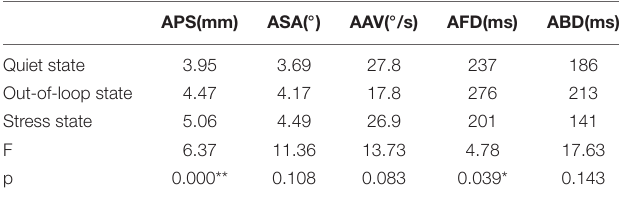
TABLE 5 | The discriminant classification results for PX, PY, and SA. P X, PY and SA Forecast